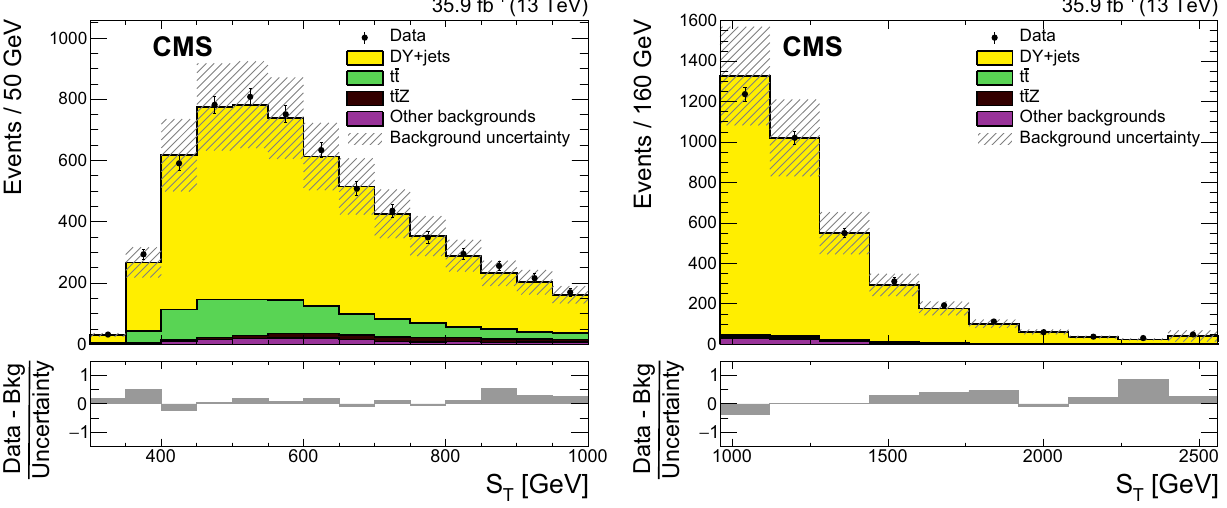
Fig. 2 The S T distributions for the CR1b+low- S T (left) and CR0b+high- S T (right)controlregionsforthedata(points)andtheback- ground simulations (shaded histograms) after applying the scale factors given in Table 4. The vertical bars on the points represent the statistical